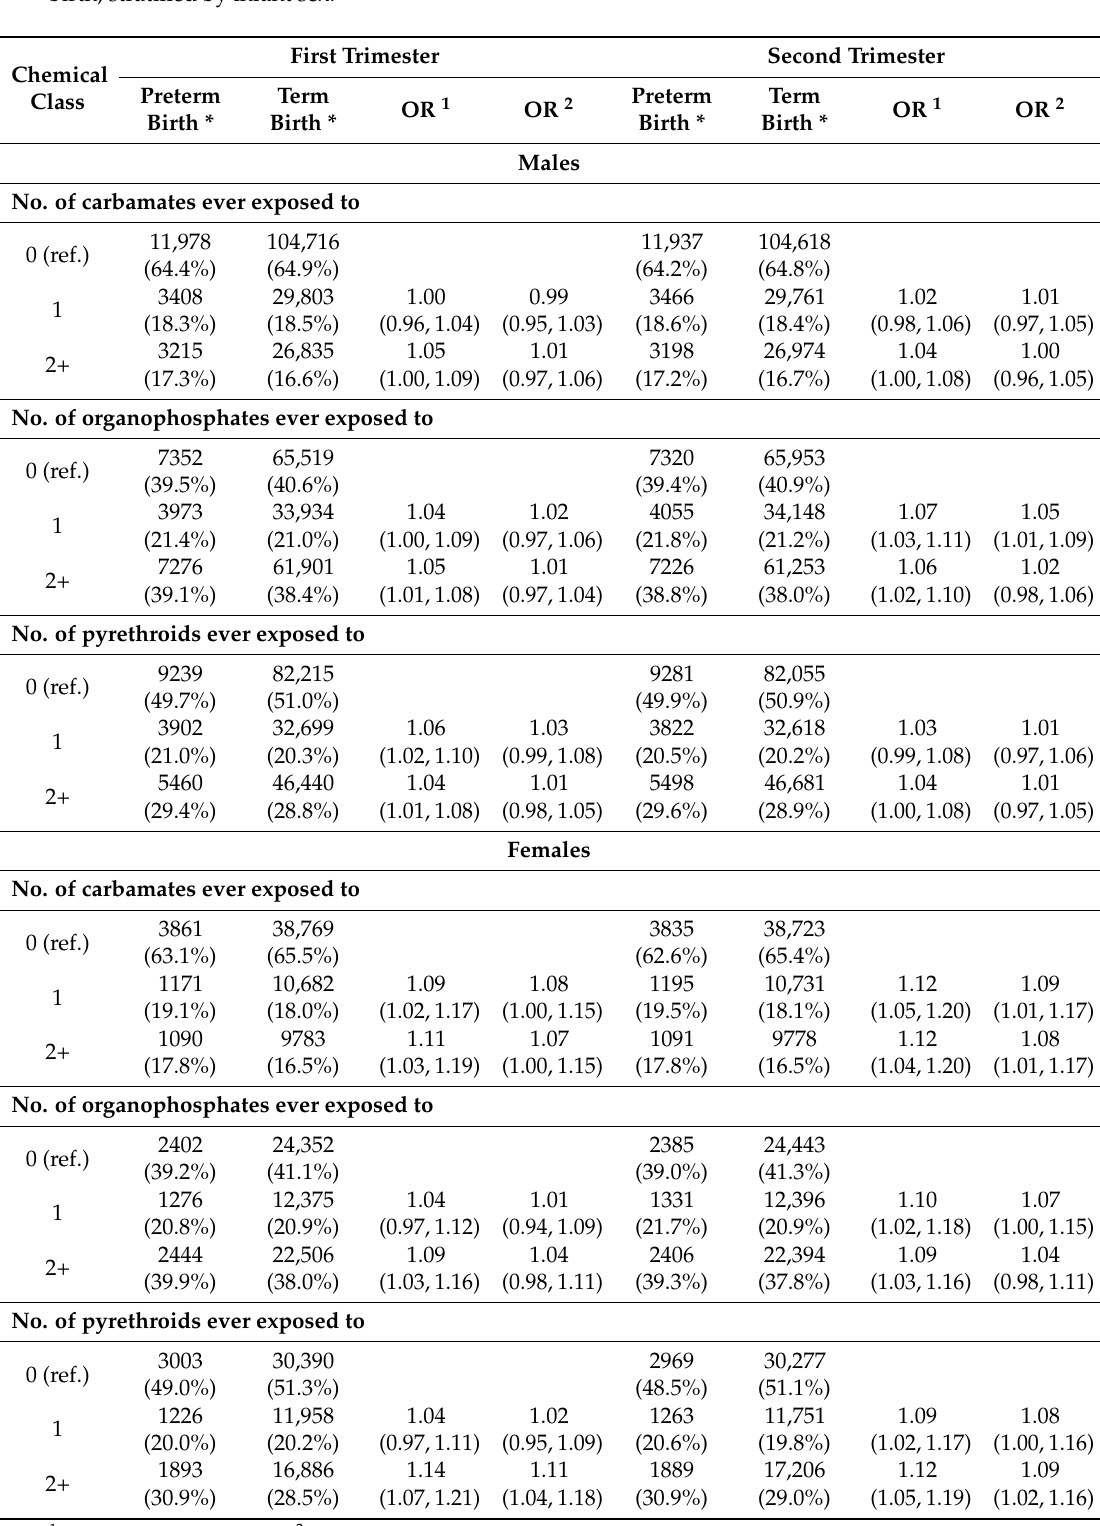
Table 4. Odds ratios (95% confidence intervals) for trimester exposures to chemical classes and preterm birth, stratified by infant